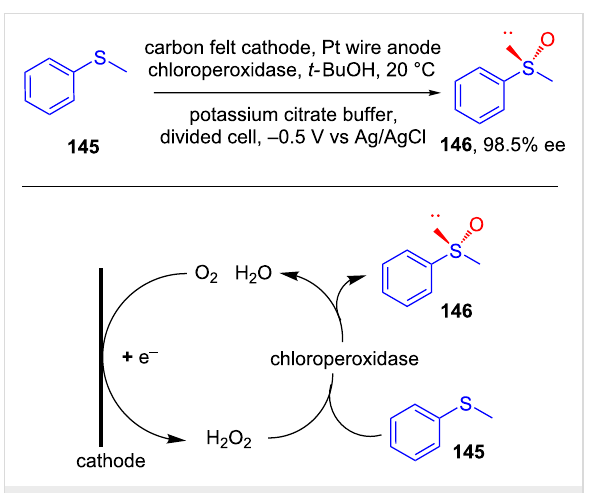
Scheme 47: Asymmetric electroreduction using a chloroperoxidase